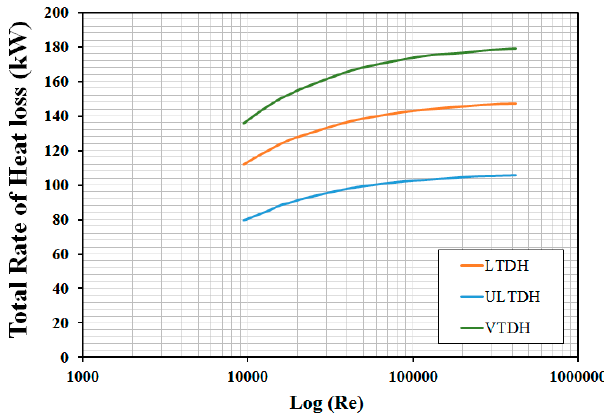
Figure 9. The effect of Reynolds number on the level of total rate of heat losses over the entire pipeline in each case.